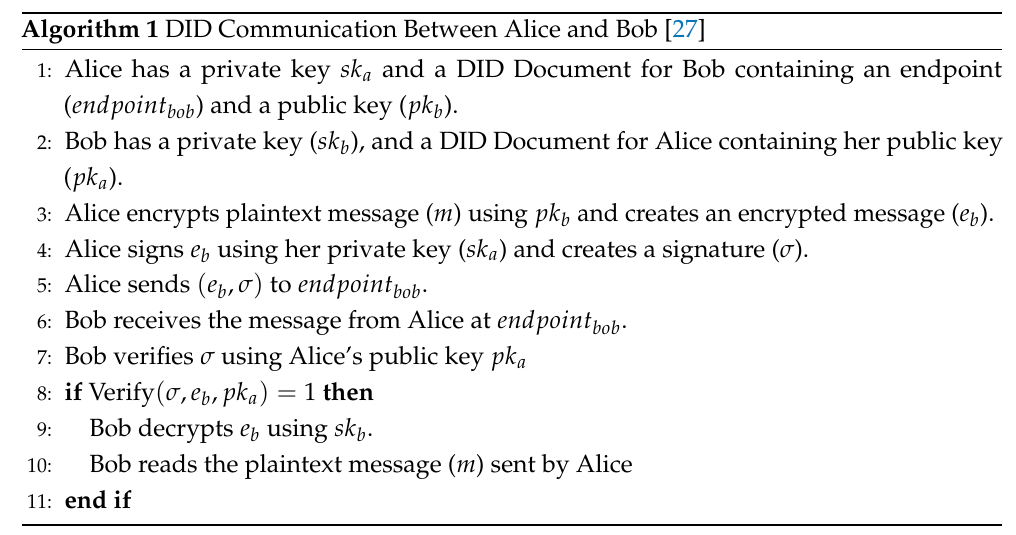
Algorithm 1 DID Communication Between Alice and Bob [27]